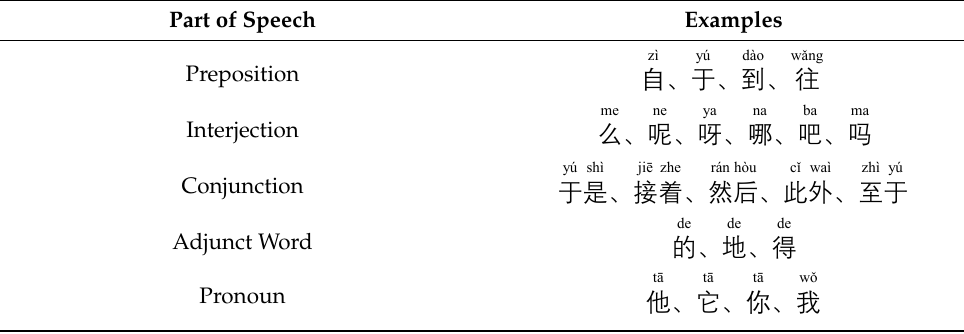
Table 4. Examples of stopping words.